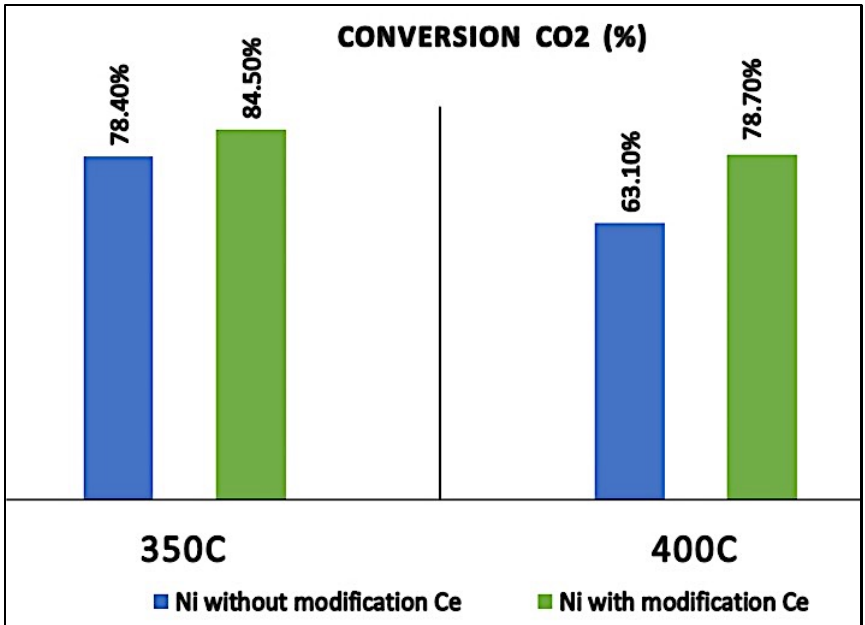
Figure 5. Conversion of CO 2 using Ni/RGO both with and without modification Ce and Ce. (Adapted with permission from Ref. [84]. Copyright 2019 Elsevier).